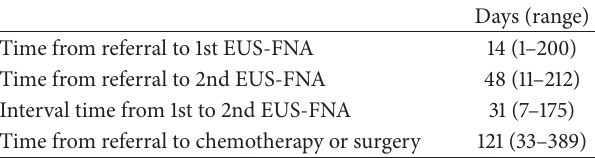
Table 4: Time to first and second EUS-FNA and eventual treatment among patients with suspected pancreatic malignancy at St. Paul’s Hospital, Vancouver, British Columbia, between 2007 and